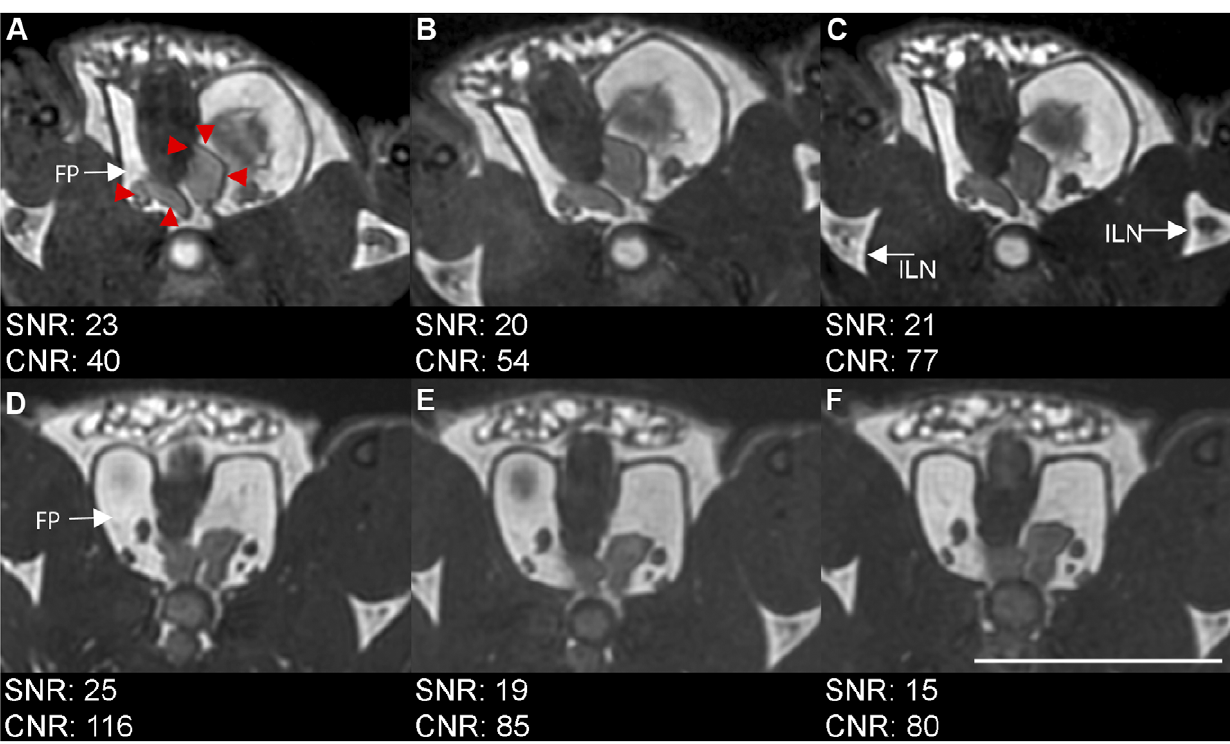
Figure 2. Effect of flip angle and bandwidth on prostate visibility and artifacts. Flip angle of A: 30 u vs B: 40 u vs C: 50 u at BW of 6 62.5 kHz. Bandwidth of D: 6 31.25 kHz vs E: 6 62.5 kHz vs F: 6 83.3 kHz. Red arrowheads indicate prostate boundaries. White arrows point to fat pad used for CNR calculations (FP) and to inguial lymph nodes (ILN). Scale bar is 1 cm. Scan parameters: Axial scan, FOV 3 6 3 cm, 200 m m isotropic resolution, TR/ TE=3.3–4.6 ms/1.1–2.3 ms, 4 PC, 2 NEX, 14 minutes.